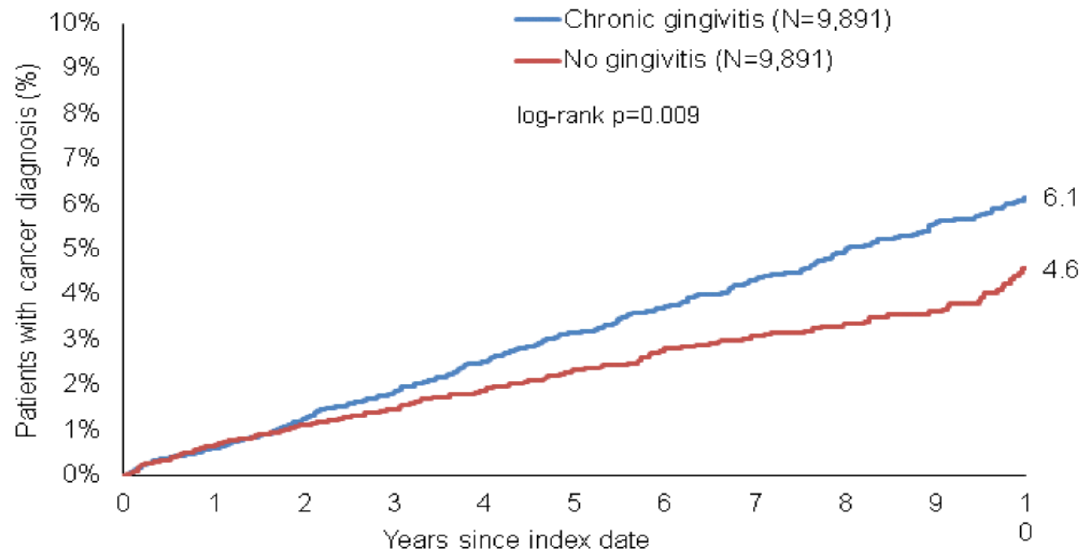
Figure 2. Cumulative incidence of cancer in patients with and without chronic gingivitis in the 10 years following the index date.